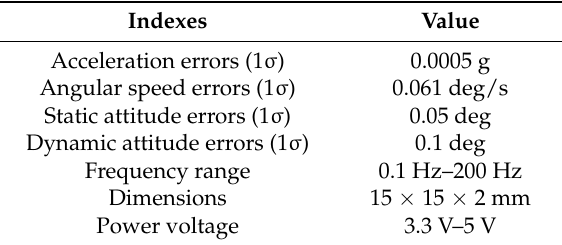
Table 1. The key technical indexes of the multi-axis IMU chip.